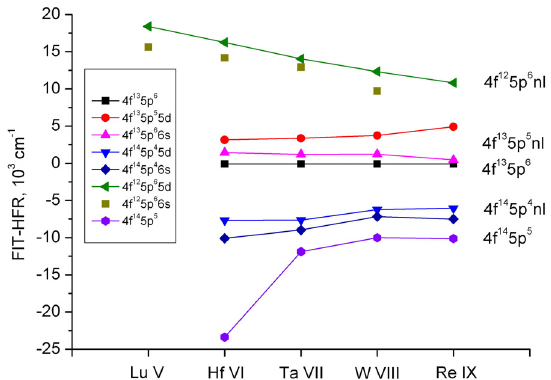
Figure 4. Differences between the experimental and HFR average energies of configurations in the W VIII isoelectronic sequence.